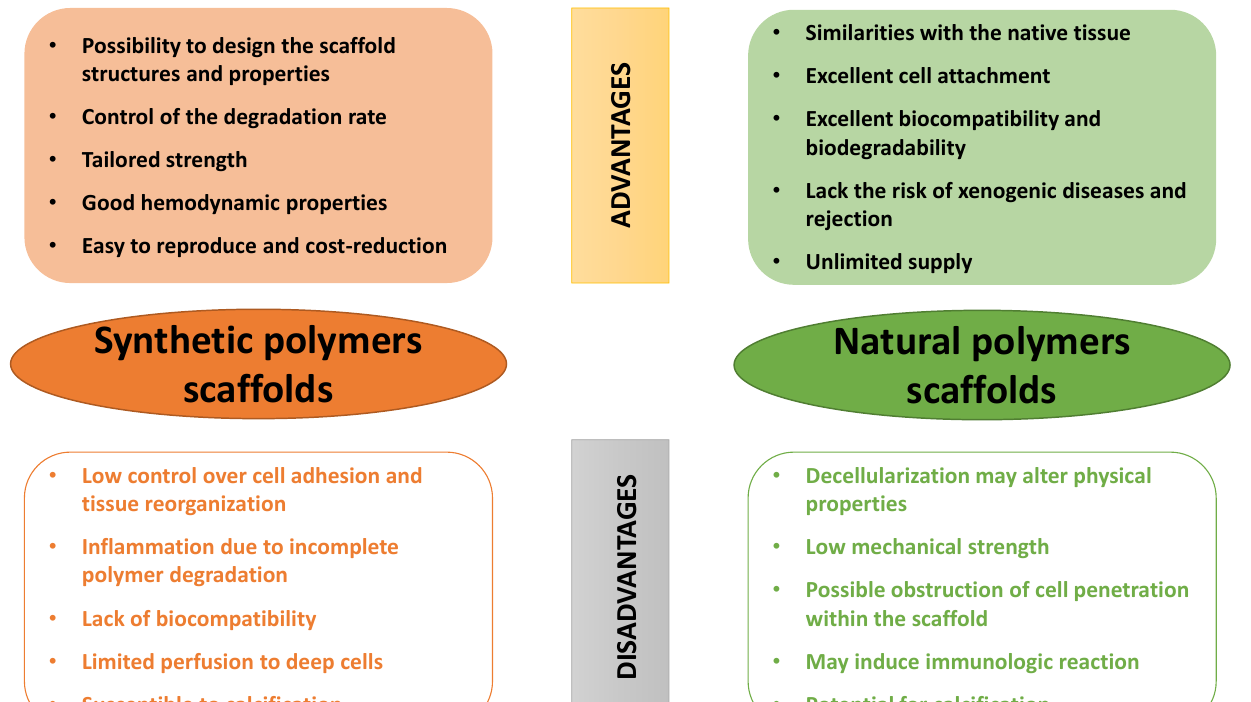
Figure 6. Comparative analysis of the polymeric scaffolds used in HVTE.